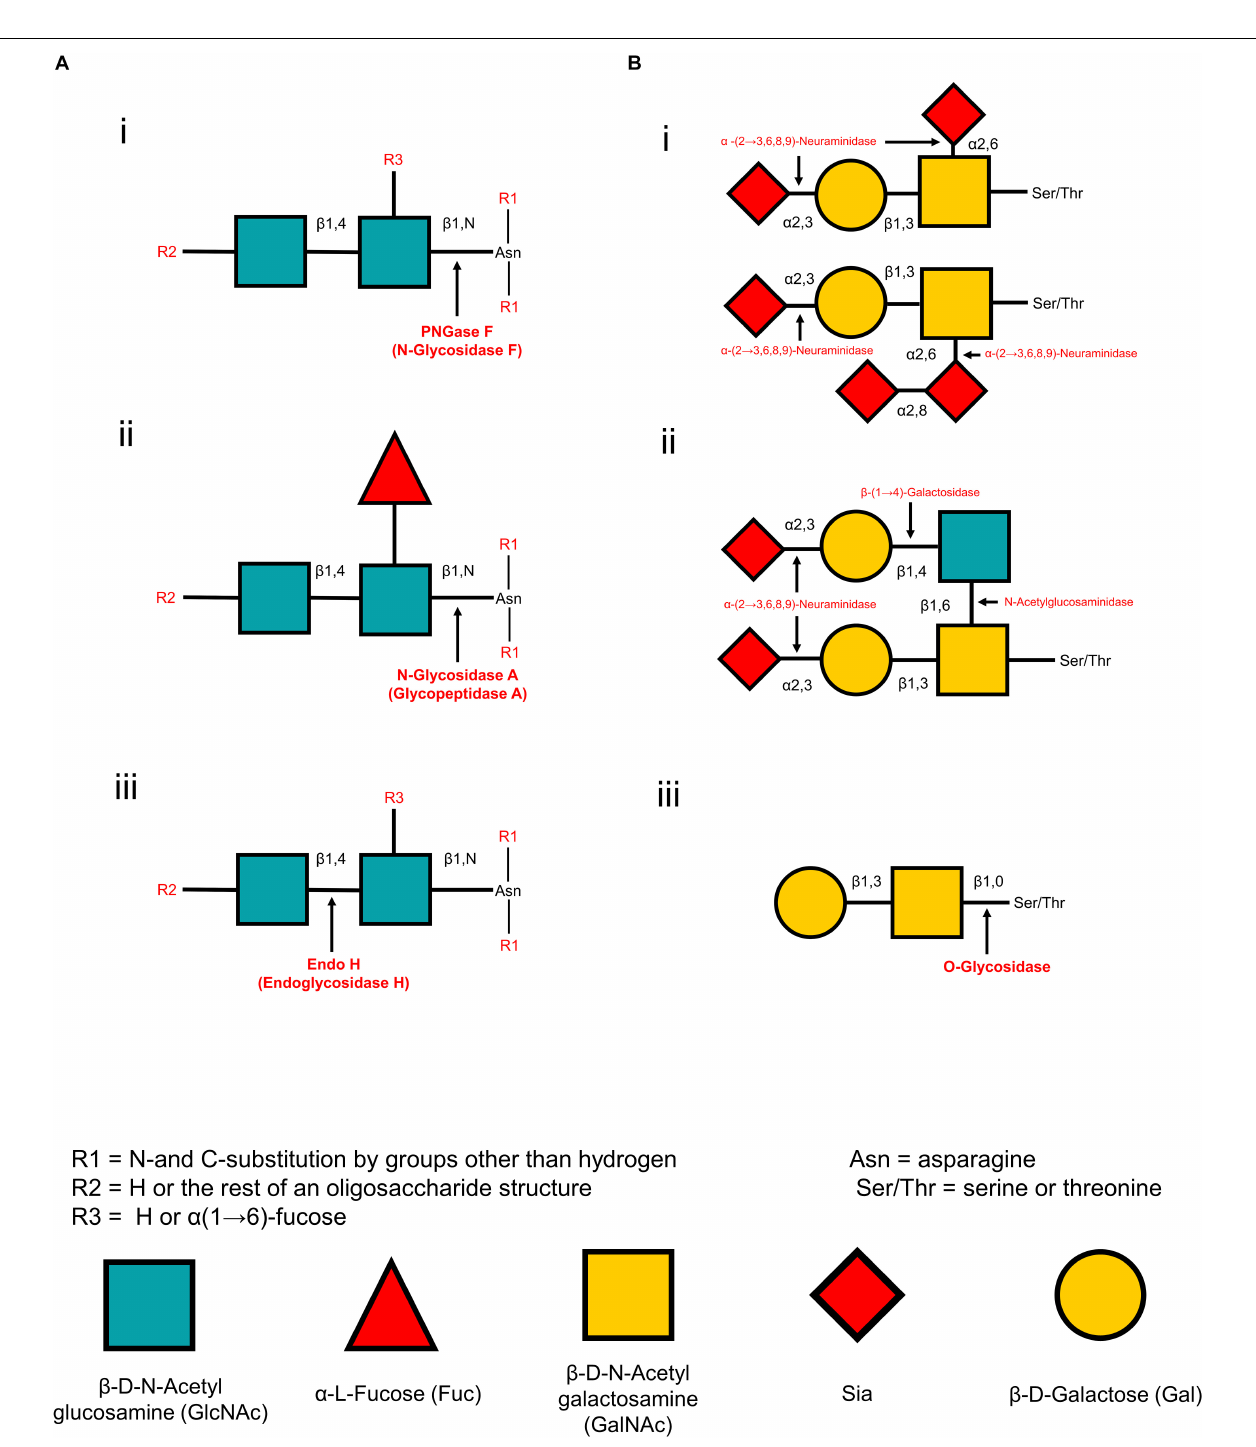
FIGURE 2 | Cleaving sites for enzymatic deglycosylation of glycans. N-glycan strategies (A) and O-glycan strategies (B) . PNGase F cleaves all asparagine-linked complex, hybrid, or high mannose oligosaccharides unless the core contains an α (1 → 3)-fucose. Cleaving site for PNGase F (A-i) . N-glycosidase A hydrolyzes oligosaccharides containing a fucose residue α (1 → 3)-linked to the asparagine-linked N-acetylglucosamine (A-ii) . Endo H cleaves the β -1,4 glycosidic linkage of high-mannose N-linked glycans between GlcNAc1 and GlcNAc2 (A-iii) . In a sequential glycolytic cleavage, disialylated and trisialylated O-linked glycans have the sialic acid residues (NeuNAc) removed by α (2 → 3,6,8,9)-neuraminidase to release core-1 type O-glycans (B-i) . Disialylated O-linked Core-2 hexasaccharide or sialic acid residues are sequentially degraded by α (2 → 3,6,8,9)-neuraminidase, β (1 → 4)-galactosidase and N-acetylglucosaminidase to release core-1 type O-glycans (B-ii) . Cleavage site for O-glycosidase on the core-1 type O-glycans after sequential glycolytic degradation (B-iii) .